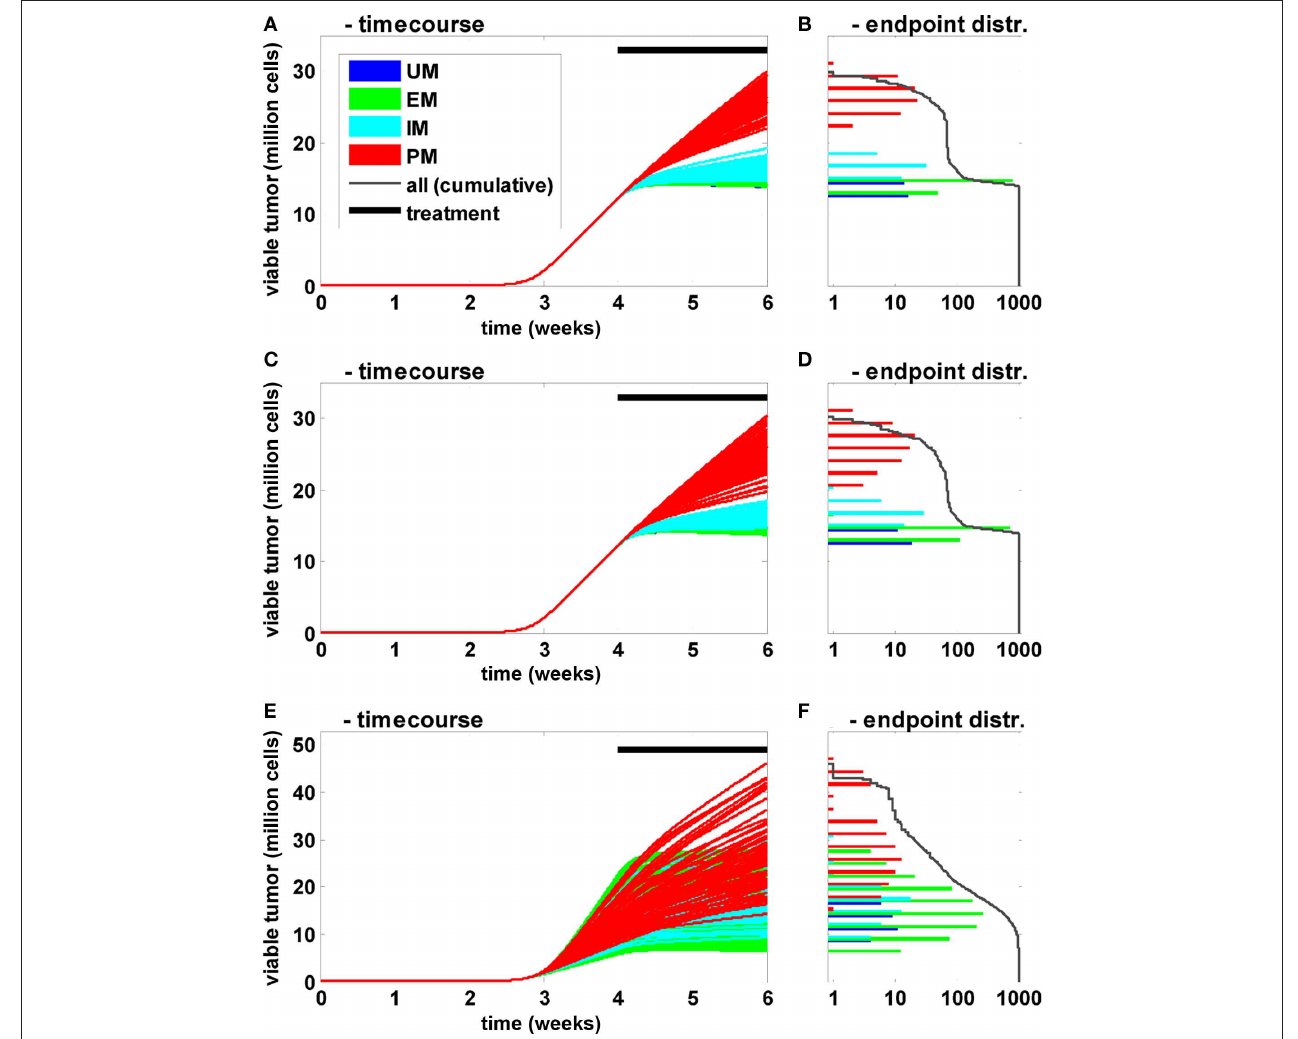
according to Sistonen et al. (2007) for Europeans. In (A) only clearance was varied between the individuals. In (C) additional physiological parameters (organ volumes and composition, blood flows, etc.) were varied independent of the metabolizers’ phenotype according to Willmann et a l. (2007b, 2009a). In ( e) the concentrations of the proteins involved in EGFR signal transduction were varied in addition to the two before mentioned sources of